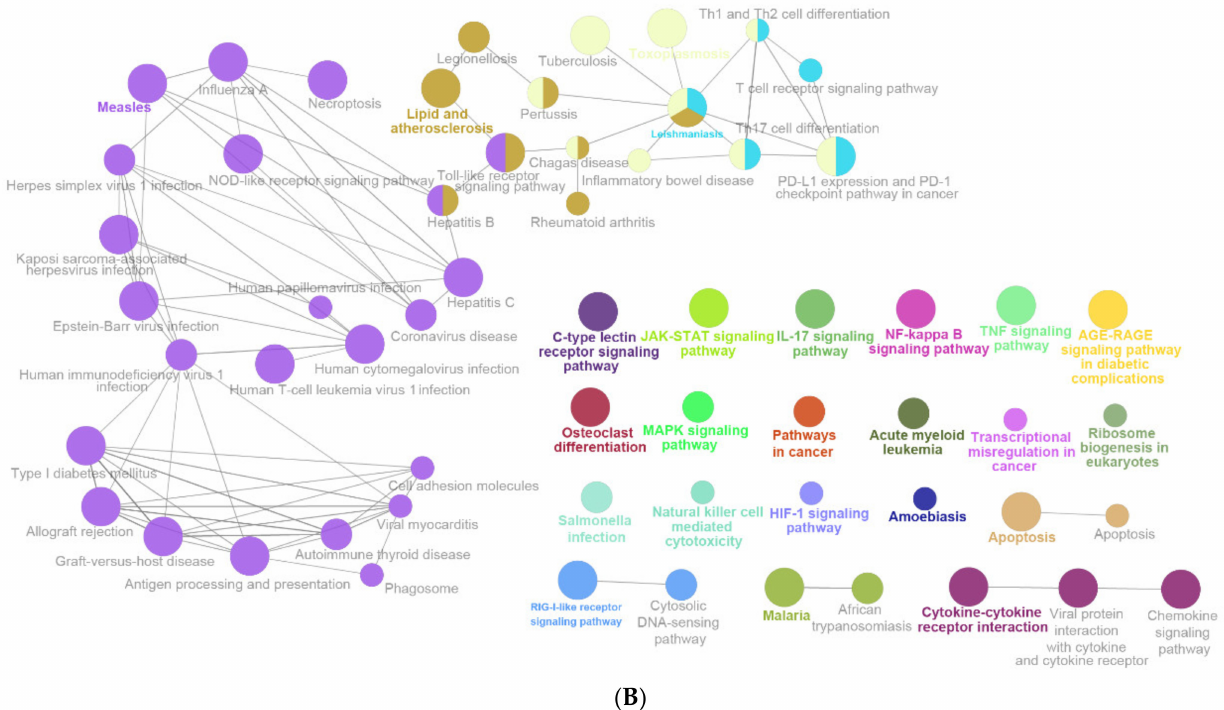
Figure 8. The enrichment analysis results of DEGs by using ClueGO (KEGG database). ( A ) Enriched biological pathways of down-regulated DEGs in group 1 (LPS vs. Control), including calcium signaling pathway, hematopoietic cell lineage, basal cell carcinoma, axon guidance, rap1 signaling, hedgehog signaling pathway, and regulation of lipolysis in adipocytes. ( B ) Enriched biological pathways of up-regulated DEGs in group 1 (LPS vs. Control), including C-type lectin receptor signaling pathway, JAK-STAT signaling pathway, IL-17 signaling pathway, NF-kappaB signaling pathway, TNF signaling pathway, AGE-RAGE signaling pathway in diabetic complications, osteoclast differentiation, MAPK signaling pathway, pathways in cancer, acute myeloid leukemia, transcriptional misregulation in cancer, ribosome biogenesis in eukaryotes, salmonella infection natural killer cell-mediated cytotoxicity, HIF-1 signaling pathway, amoebiasis, apoptosis, RIG-1-like receptor signaling pathway, malaria, and cytokine–cytokine receptor